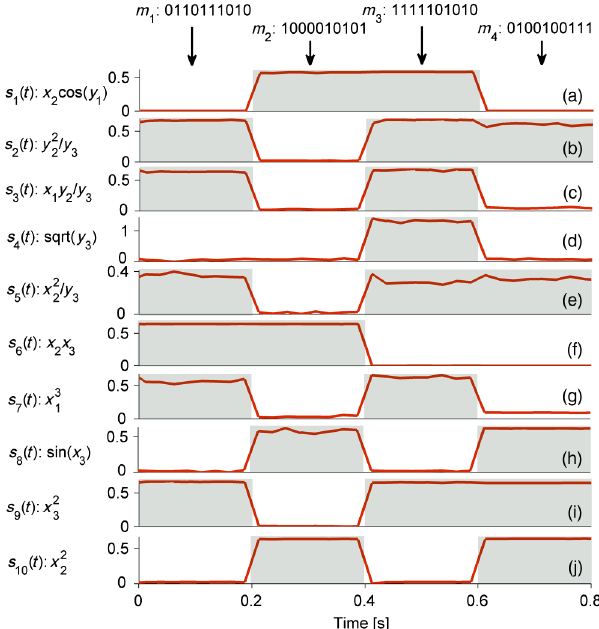
FIG. 4 Transmission of ten pseudorandom binary signals encrypted in different coupling functions. The high values (binary ‘ 1 ’ ) at the transmitter, prior to encrypting, are indicated by grey shading. The received signals, after decrypting, are shown by red lines, each of which (a-j) represents one information signal s i ð t Þ . The particular coupling functions that were used for encrypting each signal are indicated on the ordinate axis. Each bit is transmitted during an interval of 0.2 s, and four bits are trans- mitted in total for each signal e.g., s 7 ð t Þ → 1010 . The information could correspond either to ten separate serially-encoded mes- sages, or to a single 10-bit parallel-encoded message, but all of it is being transmitted simultaneously. The bits are indicated by m − m 1 4 on the top of the